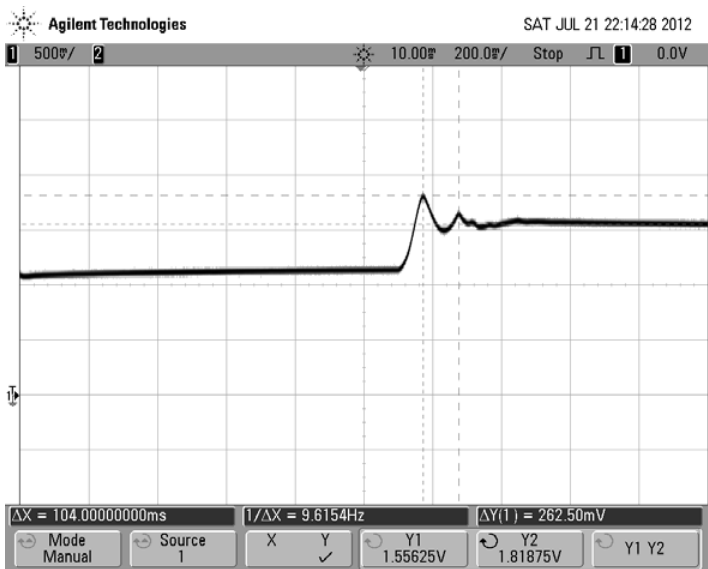
Figure 14. Response of the sensor to a step force.